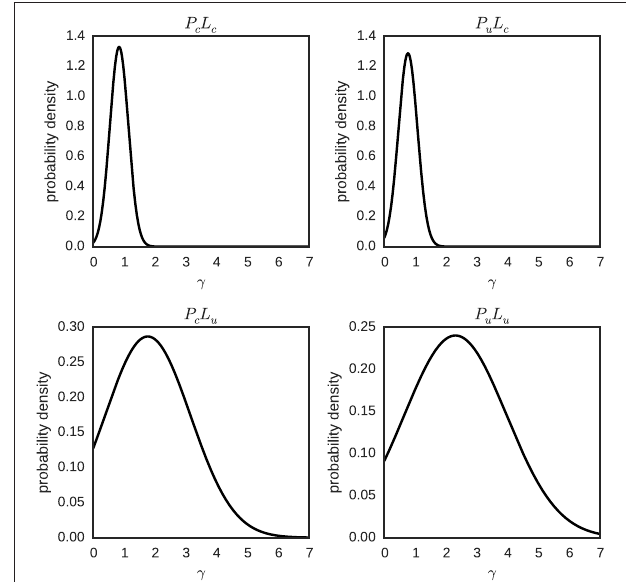
FIGURE 10 | Hierarchical distributions for parameter γ in different conditions ( P c L c , P u L c , P c L u and P u L u ). The hierarchical distributions for γ ∼ N ( µ γ ,σ γ ) use the posterior means of the hyper-parameters µ γ and σ γ